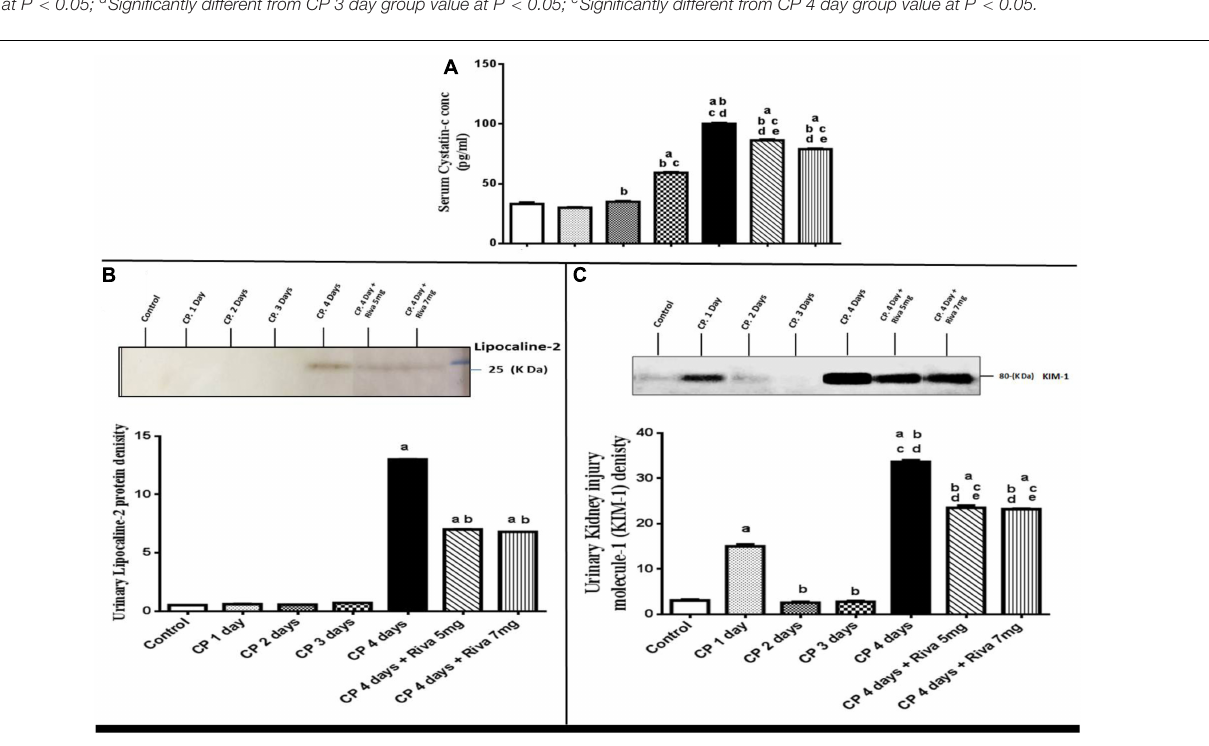
FIGURE 1 | Effect of single i.p. dose of cisplatin (CP) 6 mg/kg b.w after 1, 2, 3 and 4 days with or without rivaroxaban 5 mg /kg b.w and 7 mg/kg b.w on renal function tests including; serum cystatin-c (A) , urinary lipocaline-2 (B) and urinary KIM-1 (C) . Data are expressed as mean ± S.E. Multiple comparisons were done using one way ANOVA followed by Tukey-Kramer as a post-ANOVA test (a) Significantly different from control group at p < 0.05. (b) Significantly different from CP 1 day group at p < 0.05. (c) Significantly different from CP 2 day group at p < 0.05. (d) Significantly different from CP 3 day group at p < 0.05. (e) Significantly different from CP 4 day group at p <